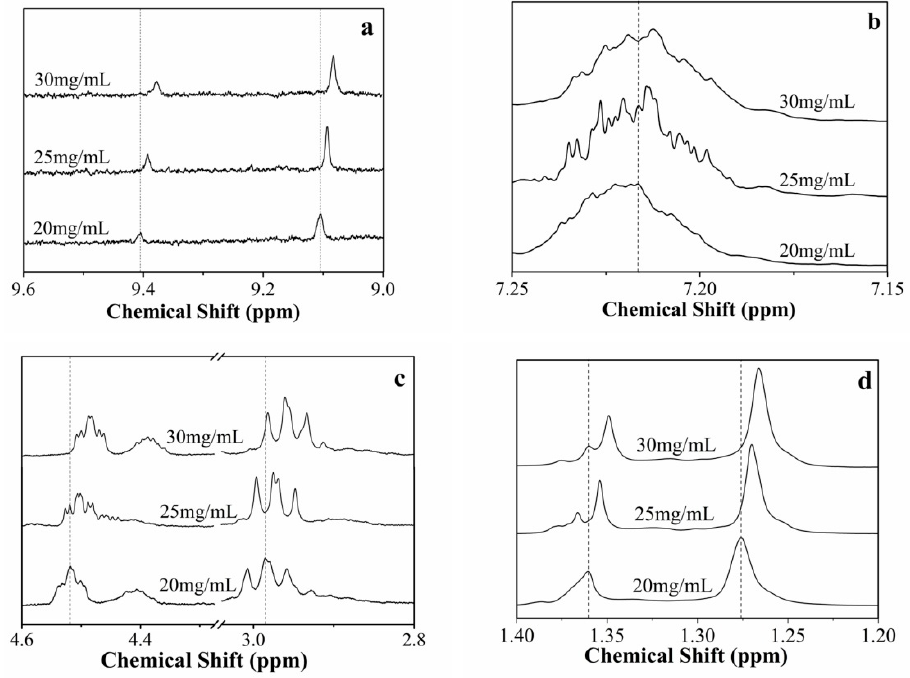
Figure 6. The 1 H NMR spectra of benzene gel formed by compound 4 at different concentrations: ( a ) amide protons, ( b ) aromatic protons, ( c ) alkyl protons, ( d ) methyl protons.